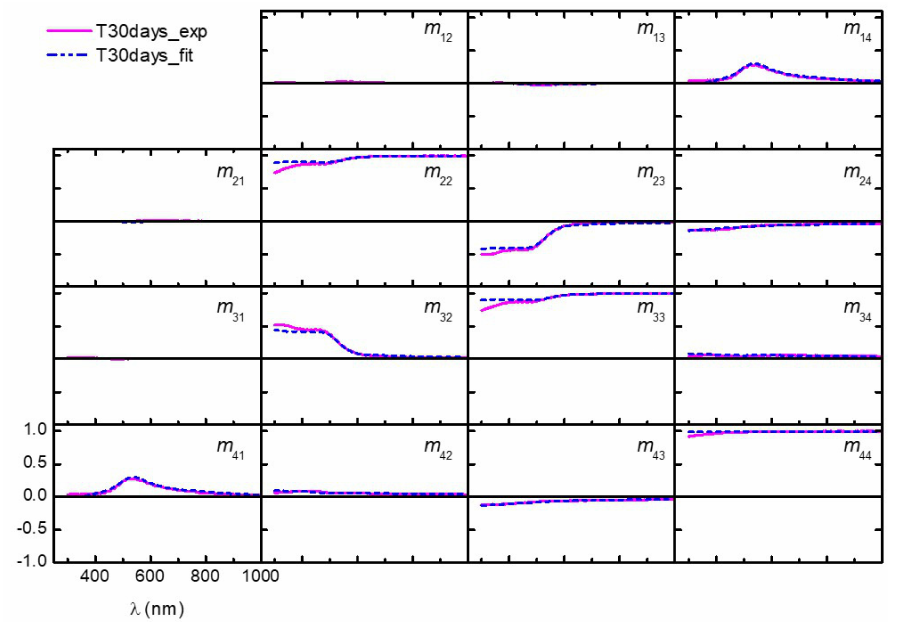
Figure 13. The transmission Mueller matrix of a 20 µ m cellulose nanocrystal film (solid curves). The dashed curves shows the best model fit obtained with non-linear